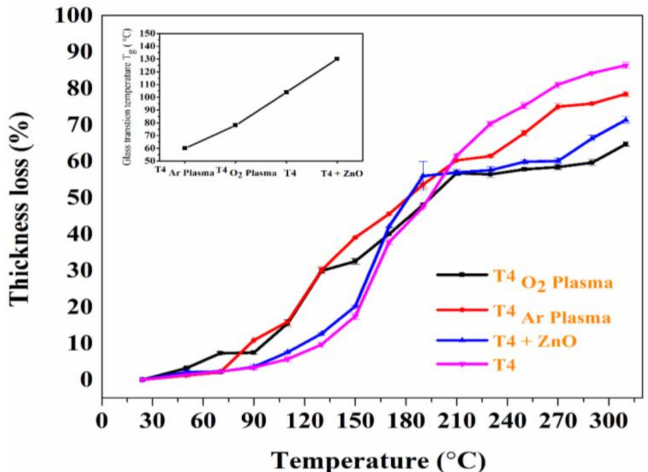
Figure 8. Percentage thickness loss as a function of temperature estimated using ellipsometry data. The inset shows the glass transition temperature T g of modified T4 plasma polymers. T g was found to increase in the following manner T4 Ar plasma < T4 O2 plasma < T4 < T4 +